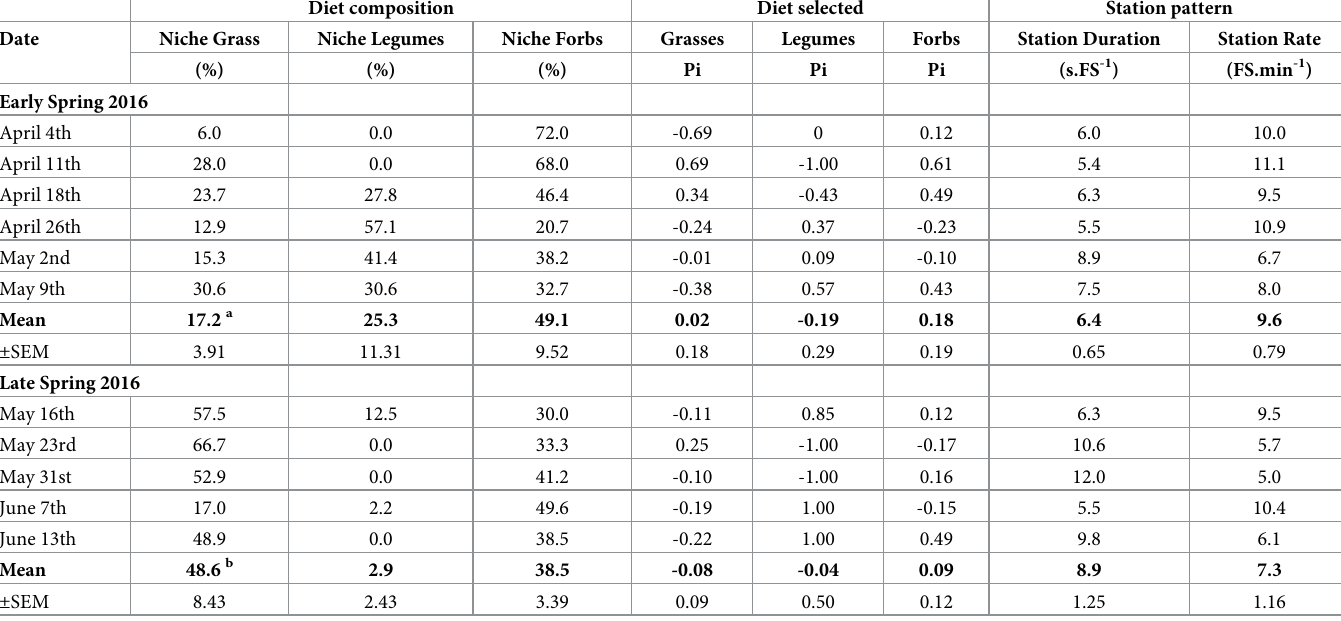
Table 4. Weekly variation in diet composition, diet selected and station pattern.